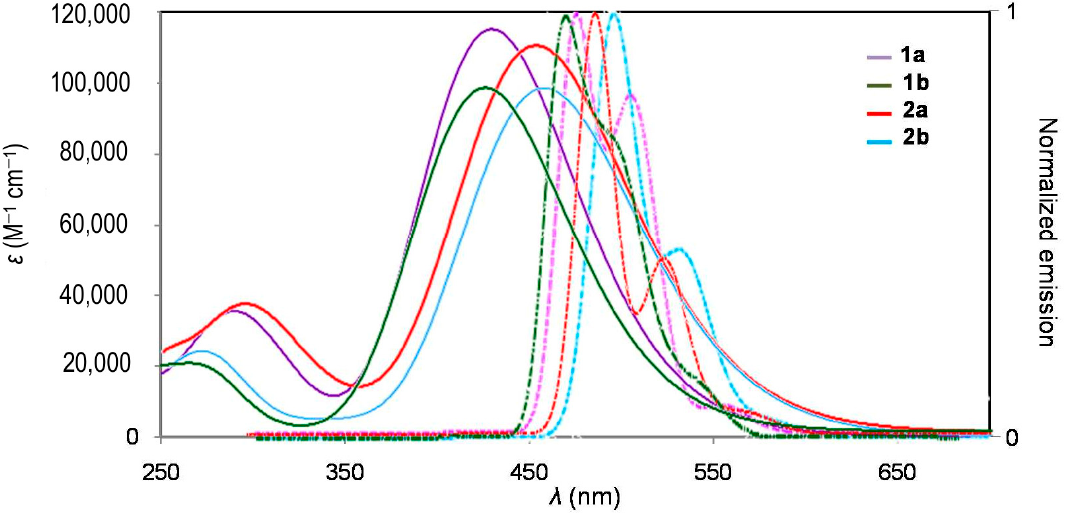
Figure 4. CAM-B3LYP/6-31 + G(d) simulated UV-vis absorption (solid line) and emission (dashed line) spectra (bottom) of 1a , b and 2a , b in toluene.